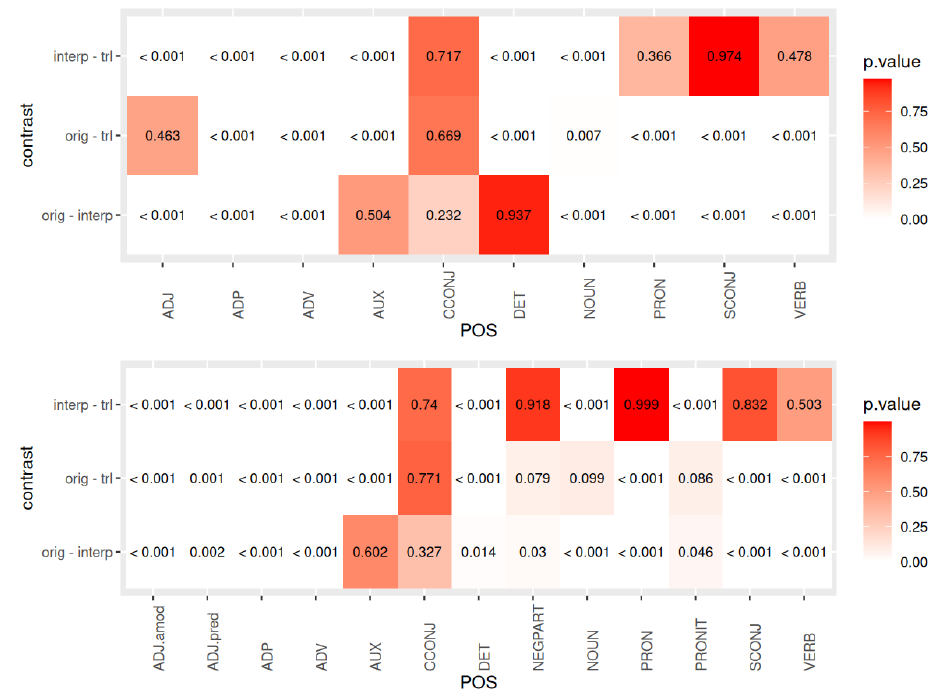
Figure A5. p -values for post hoc comparisons (top: basic tagset, bottom: extended